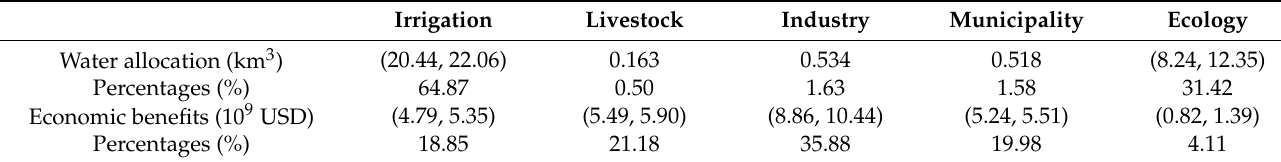
Table 15. Water allocation and economic benefits by sector.